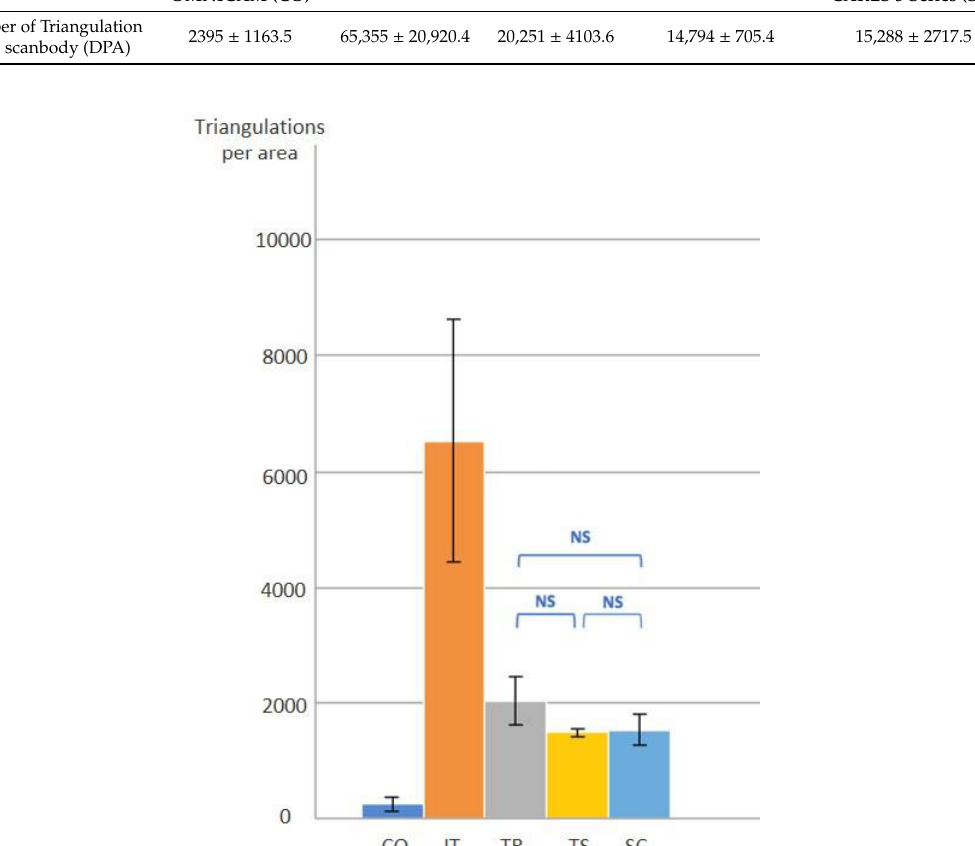
Table 3. Parameters that affect the surface topography of the scanner by Univariate Linear Regression Analysis ( p < 0.05).